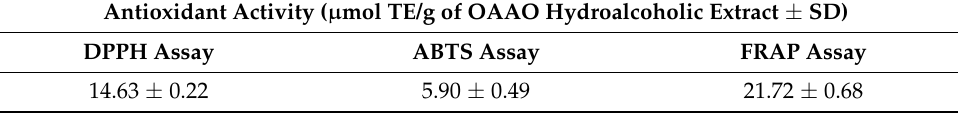
Table 7. Antiradical activity of OAAO extracts evaluated by DPPH, ABTS and FRAP